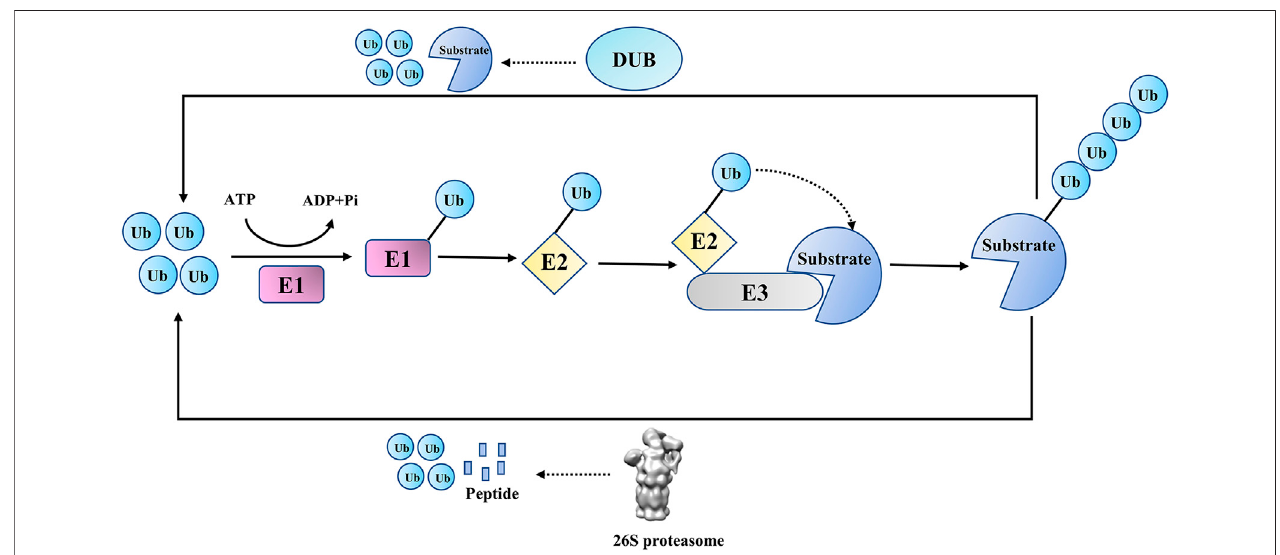
FIGURE 1 | Ubiquitin proteasome pathway and